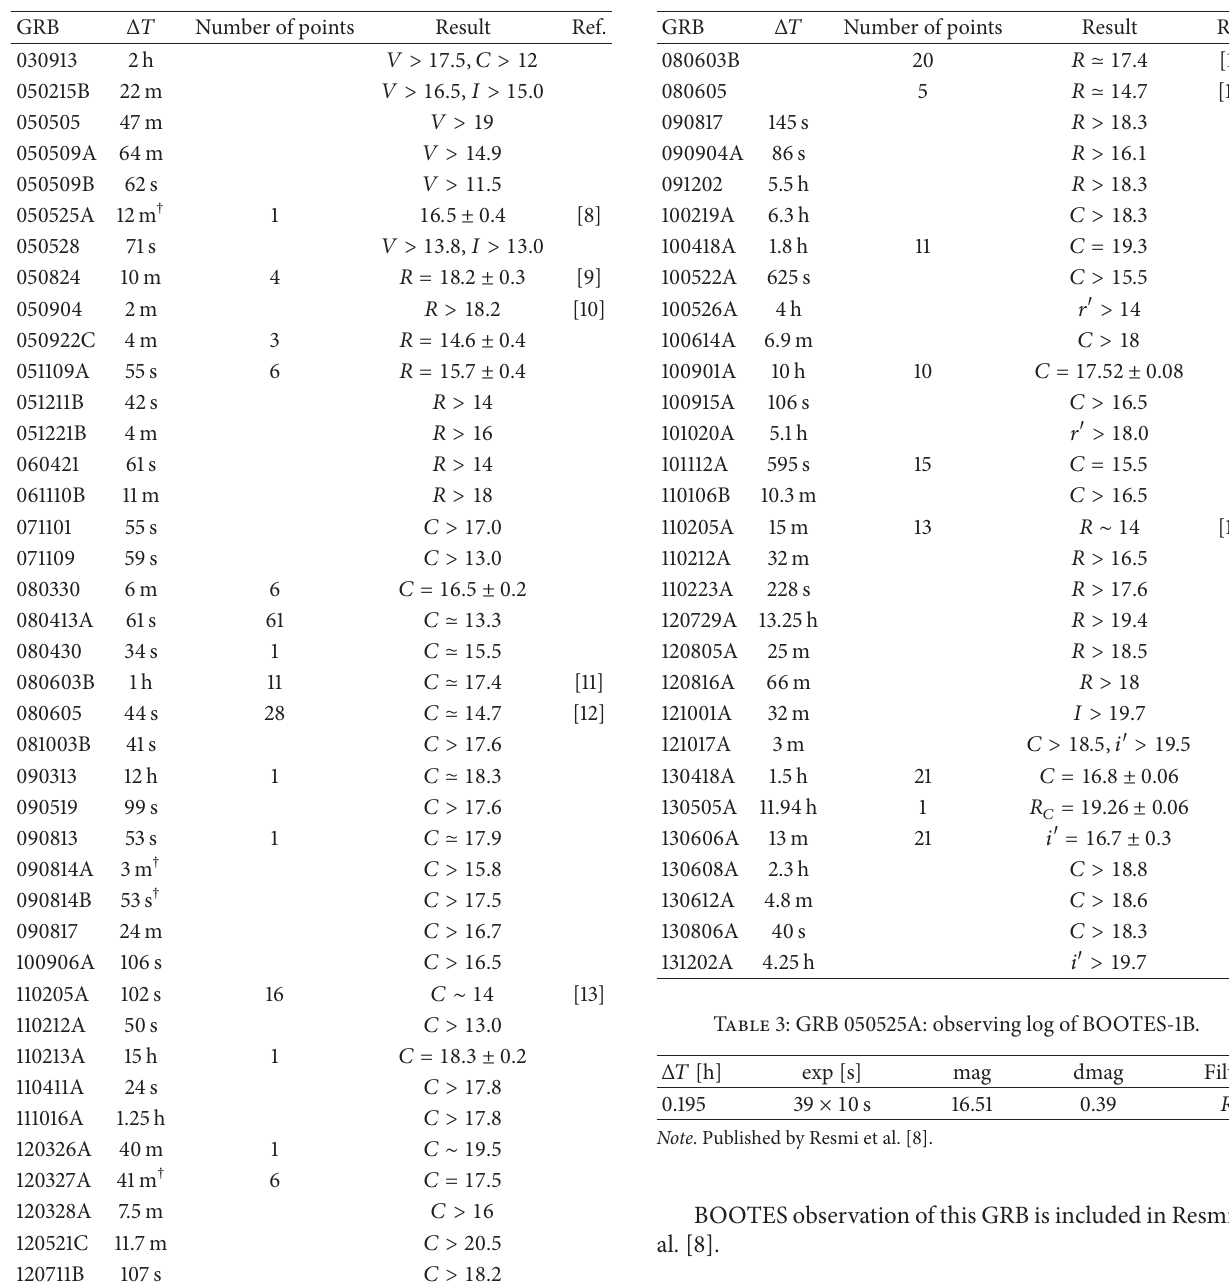
Table 1: BOOTES-1B GRBs in a table. Table 2: BOOTES-2 GRBs in a table.